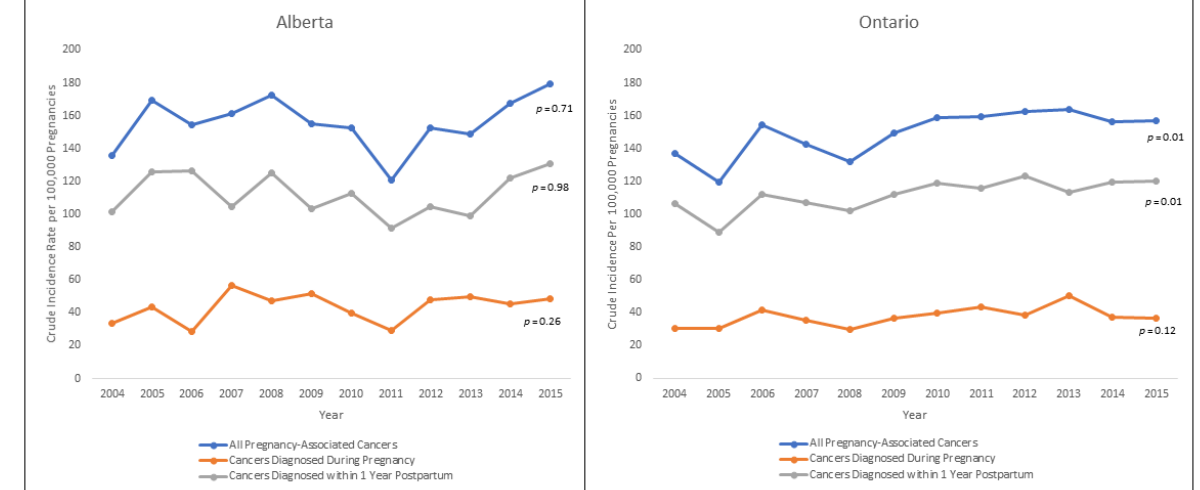
Figure 2. Temporal trends in the crude incidence rate (IR) of pregnancy-associated cancer in Alberta and Ontario, 2004–2015.